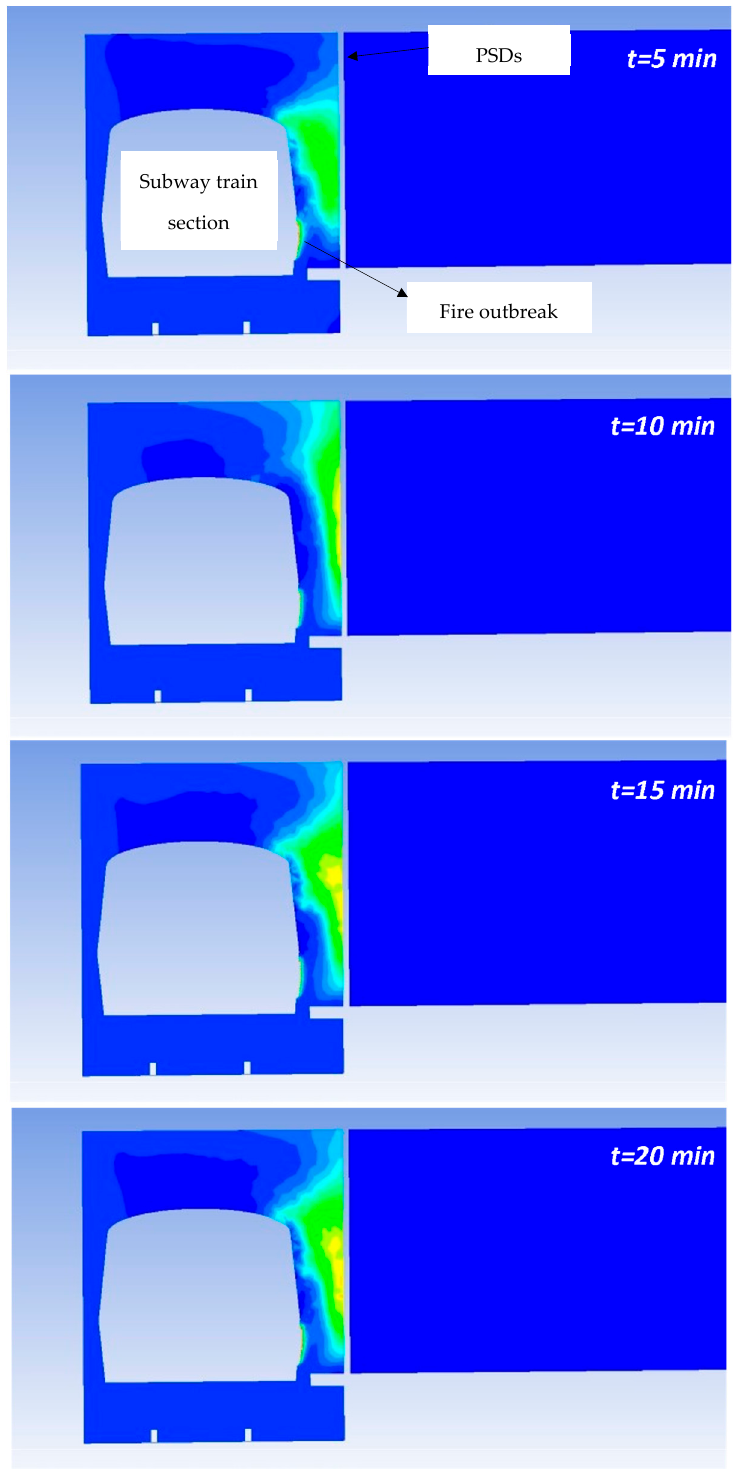
Figure 15. CO contours (ppm)—cross section through the fire outbreak (minutes 5–20).